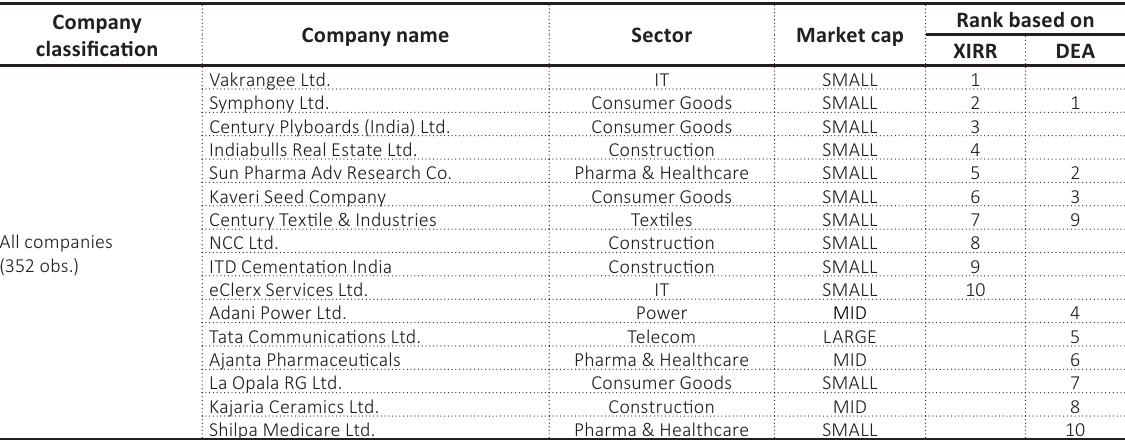
Table 5. Comparison of rankings of highest performing companies